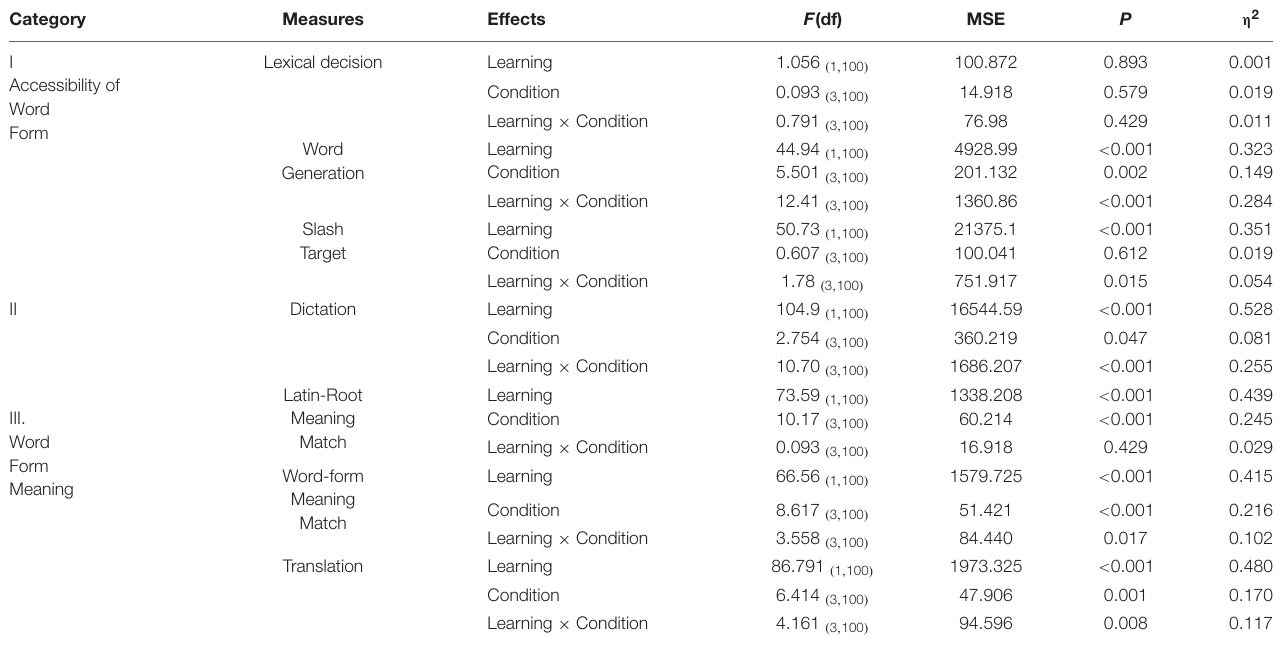
TABLE 2 | The Omnibus test of ANOVAs results for category